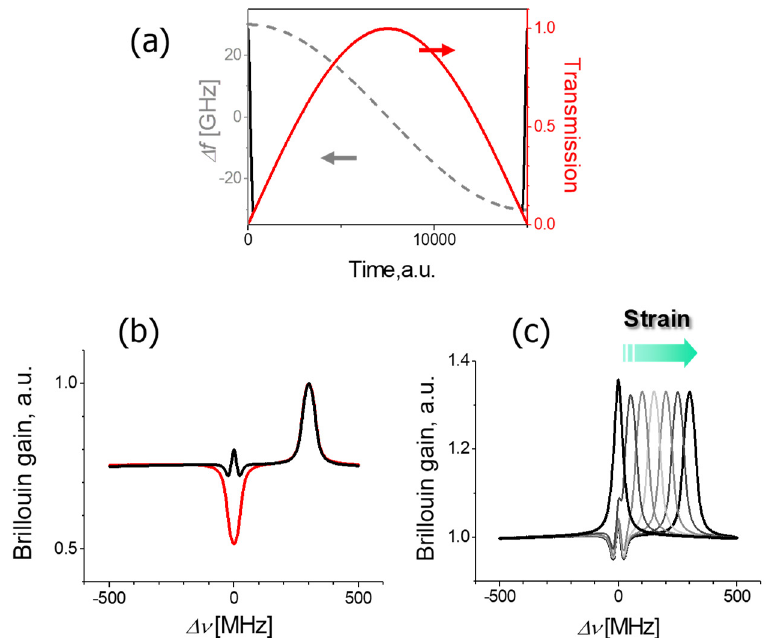
Figure 23. Simulations of the intensity modulation scheme [51]. ( a ) Two waveforms for the intensity modulation; the dashed curve is a sinusoidal FM waveform, and the red and black curves are for the IM. The red curve is a trial waveform for the IM, which is half the sinusoidal waveform to reduce the power at both edges of the time-averaged power spectrum caused by the FM. The high transmission portion that is shown by the black peak at both edges of the FM power spectrum is introduced to compensate for the over apodization; ( b ) Background spectrum reduced by the IM modulation; the red curve corresponds to the red IM waveform in ( a ), which makes over apodization at ∆ ν = 0. The black curve corresponds to the IM waveform with a black peak in ( a ). ( c ) Signal spectra with reduced background spectrum by the appropriate IM waveform shown in ( a